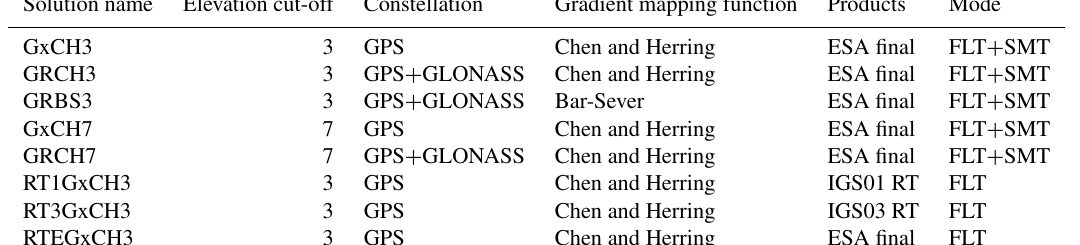
Table 1. Processing parameters of individual variants from the G-Nut/Tefnut software. Mode FLT denotes a simulated real-time solution using a Kalman filter only and FLT + SMT a post-processing solution using the Kalman filter and the backward smoother.